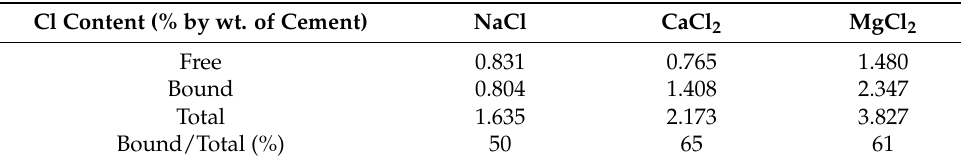
Table 3. Influence of cation type on chloride binding for 2-day-old PC paste samples (w/c = 0.5) immersed in 20 g Cl/L solution for 28 days [56].